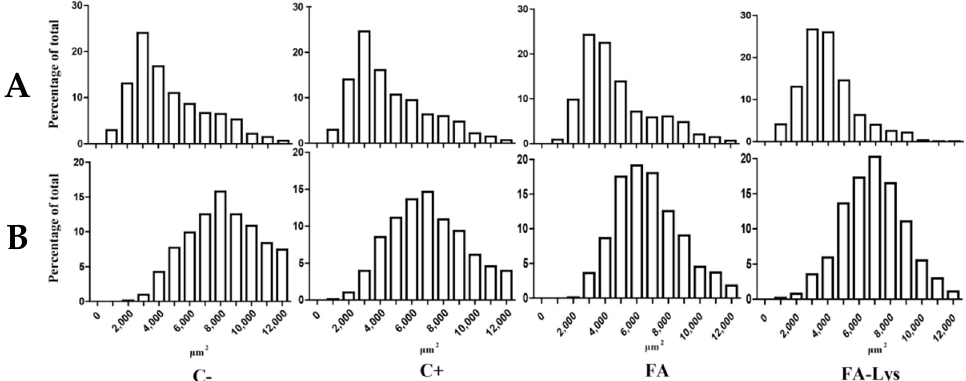
Figure 2. Cross-sectional area distribution patterns of muscle fibers (NADH-TR). ( A ) Oxidative fibers and ( B ) glycolytic fibers. Treatments: negative control treatment (C − ), without additive; positive control treatment (C+), 10 ppm/kg of feed of ractopamine hydrochloride + 0.97% lysine; FA treatment, 25 ppm/kg of feed of FA; and FA-Lys treatment, 25 ppm/kg of feed of FA + 0.97% lysine.